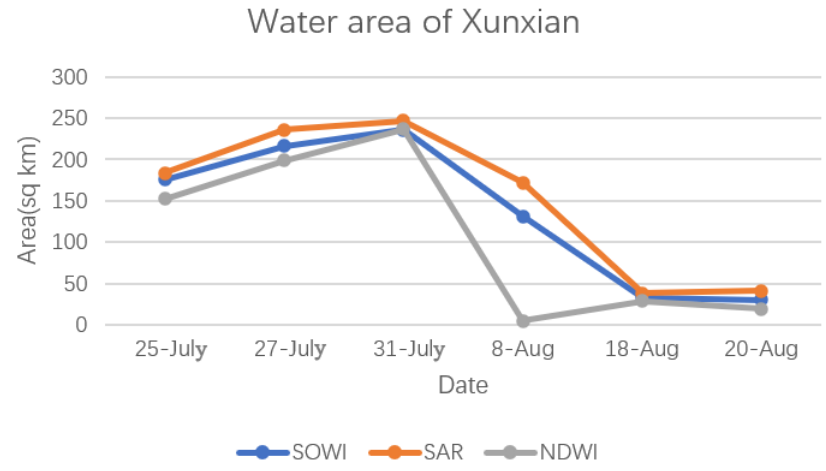
Figure 6. The curve of the flood area with time obtained by the three algorithms during the flood outbreak period in Xunxian County, Henan Province.